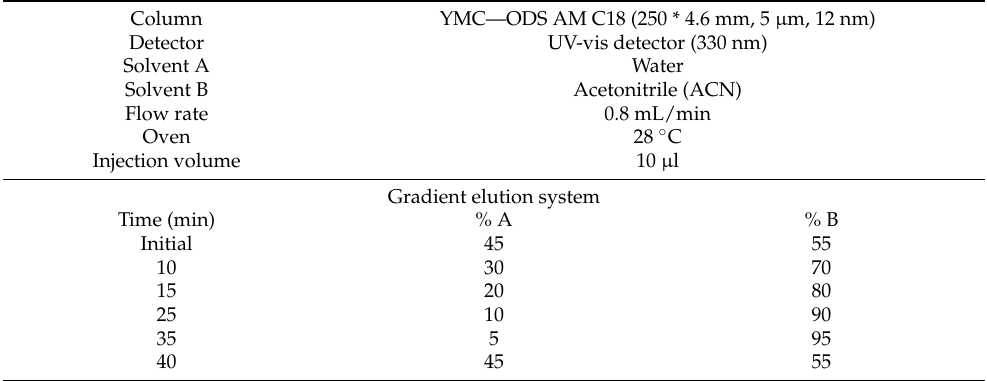
Table 2. The HPLC condition for analysis of D and DA.